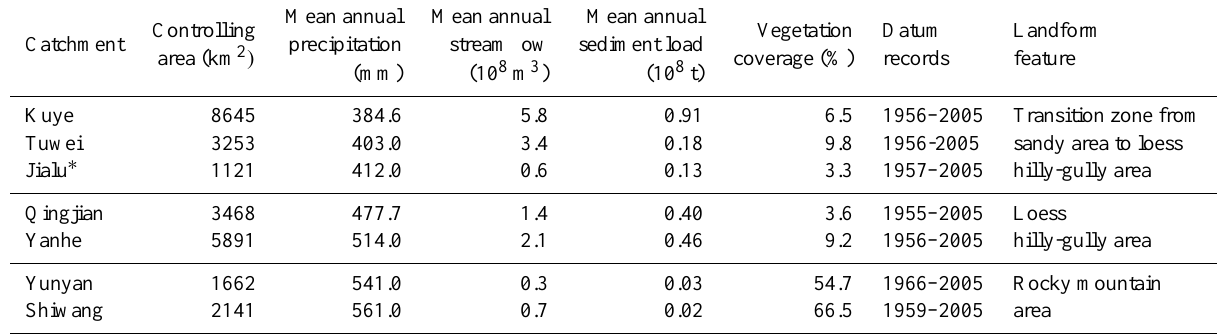
Table 1. Description of the seven catchments in the middle reaches of Yellow River,